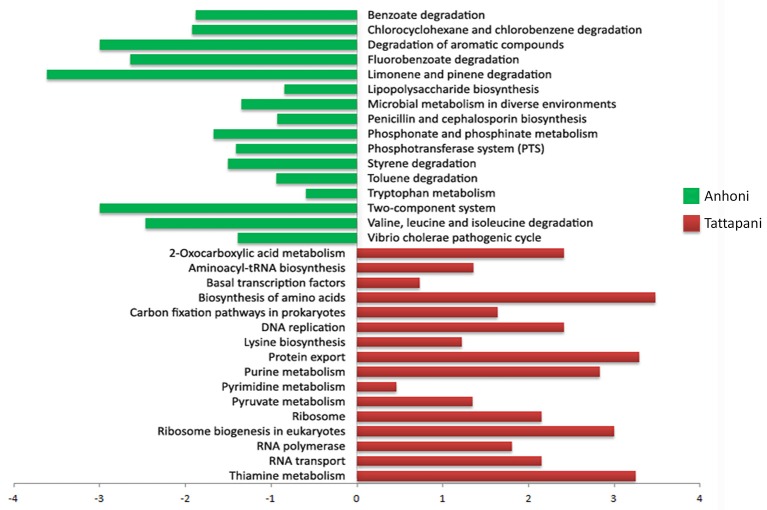
Fisher's exact test for pathways in Anhoni and Tattapani samples. The positive bars (in green) are pathways enriched in Anhoni samples, whereas the negative bars (in red) are pathways enriched in Tattapani samples.